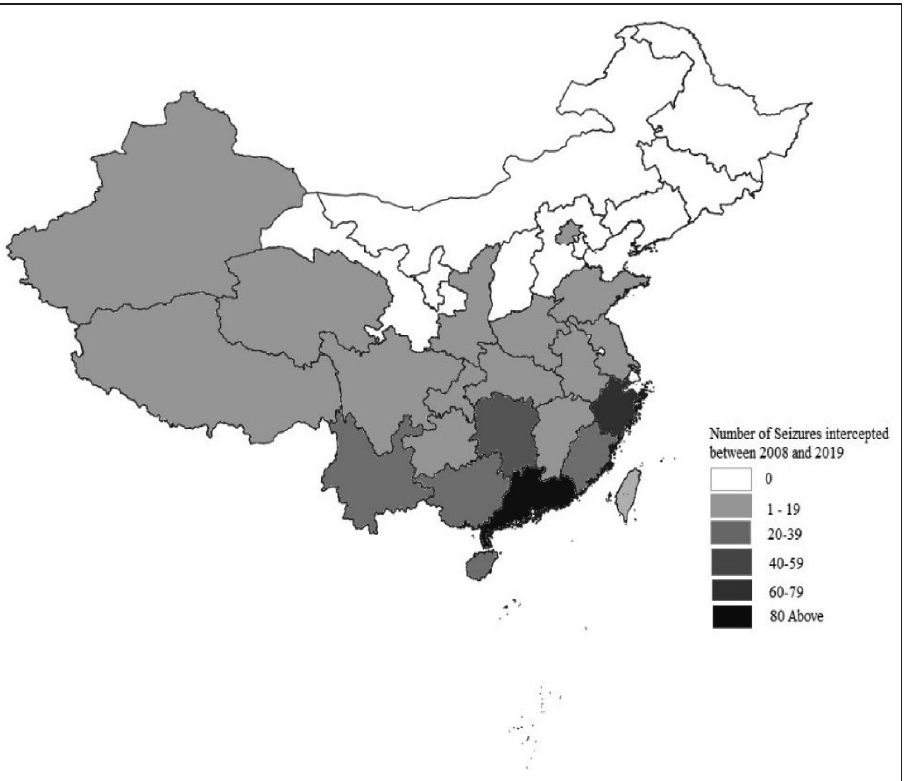
Figure 2. Spatial patterns distribution showing the number of seizures for each province in China from 2008 to